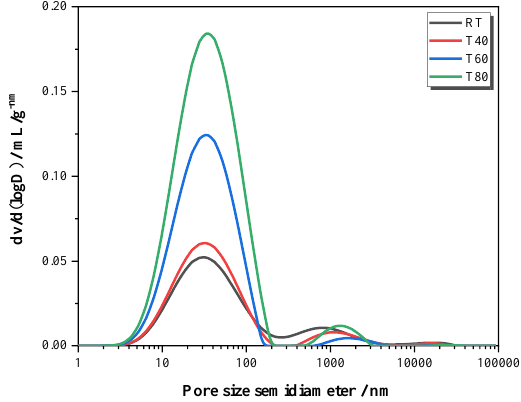
Figure 11. Pore volume curve of mortars at 28 days.